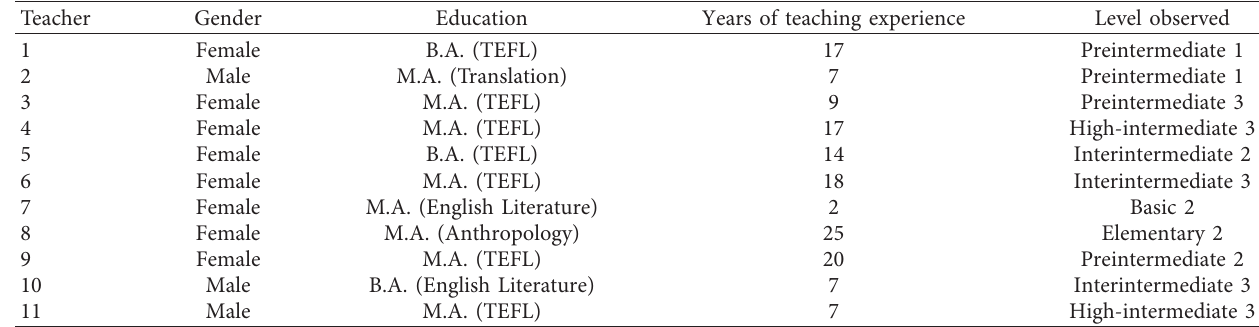
Table 3: Teachers’ background